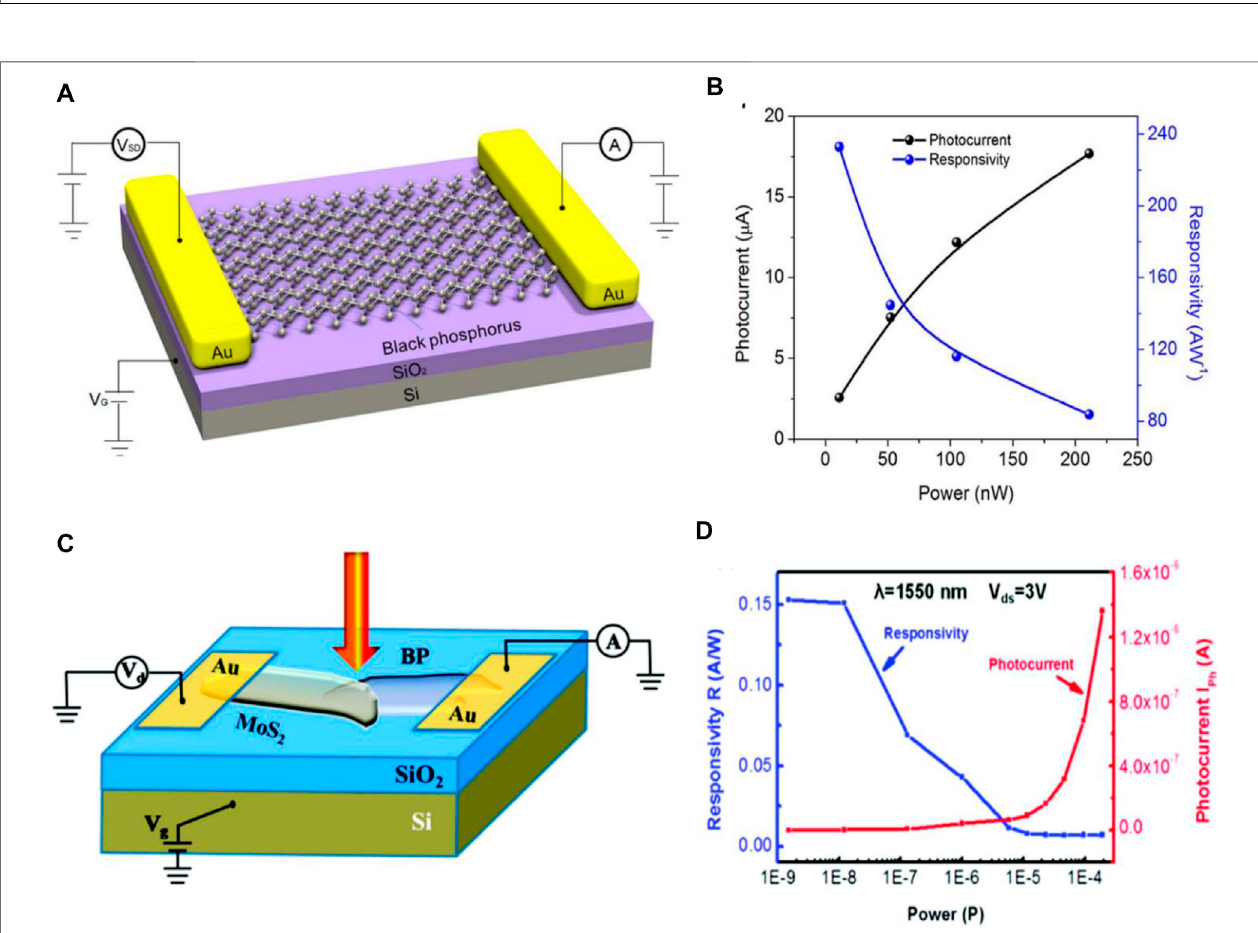
FIGURE10|(A) Schematicofblackphosphorus-basedphotodetector(YanLiuetal.,2018), (B) BPphotodetectorresponsivity(YanLiuetal.,2018), (C) Schematicof BP-MoS 2 photodetector(Yeetal.,2016b),and (D) BP-MoS 2 photodetectorresponsivity(Yeetal.,2016b);Reproducedwithpermissionfrom(Yeetal.,2016b;YanLiuetal.,